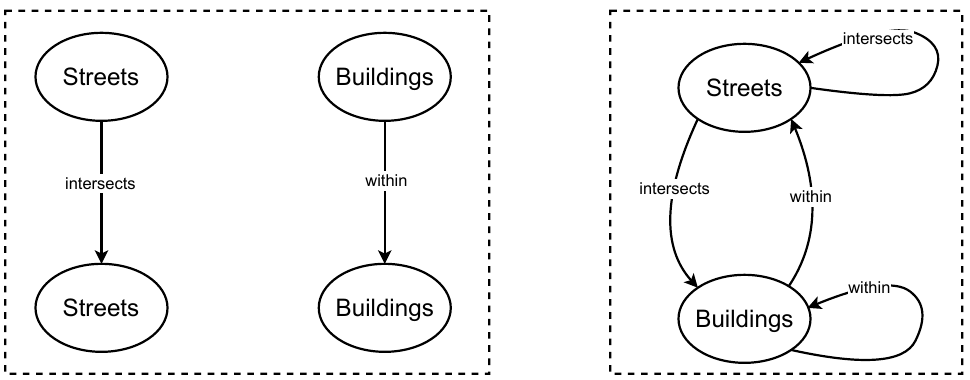
Figure 3. Figure showing the network schema for the homogeneous and heterogeneous graph representations used in our experiments. To the left, is the network schema of the homogeneous representations for streets and buildings. To the right, is the network schema of the heterogeneous graph